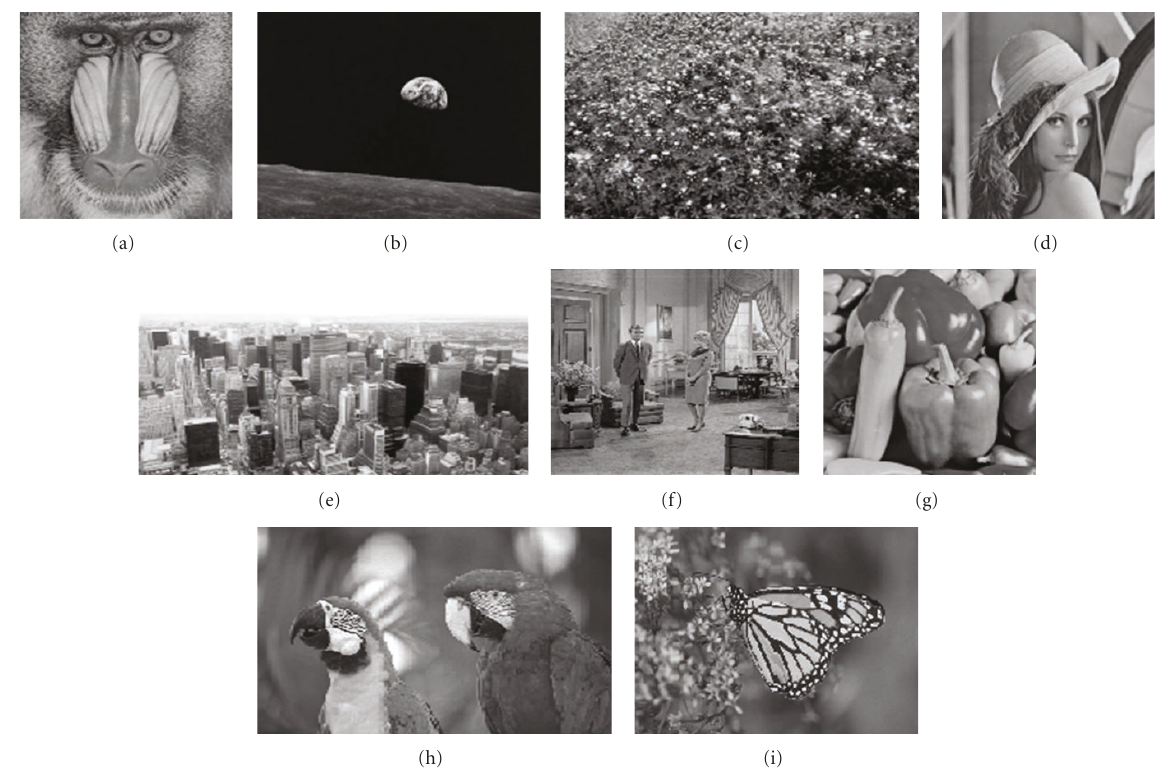
Figure 1: Nine images with di ff erent complexities. In your opinion, how complex are these